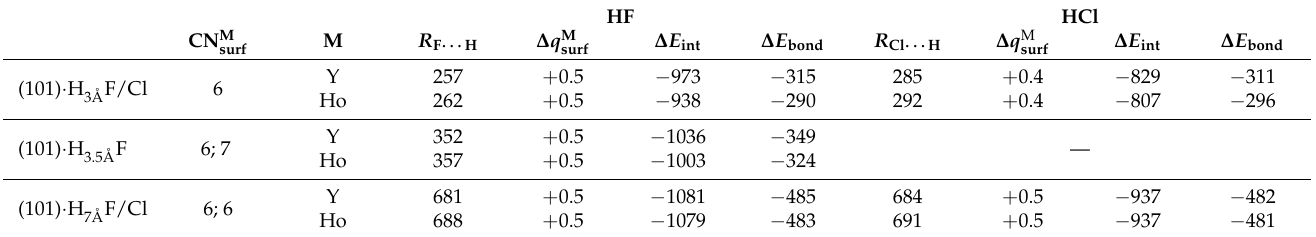
Table 1. Comparison of the different hydride-forming adsorptions by coordination number (CN M and the maximum change in partial charge for one M surf ( ∆ q M = 1.7–1.8 e for six-fold coordinated and q M(III) bare (101) charges of q M(II) surf coordinated M surf , together with the halide to hydride distances ( R X ··· H ) in pm and adsorption energies in kJ · mol − 1